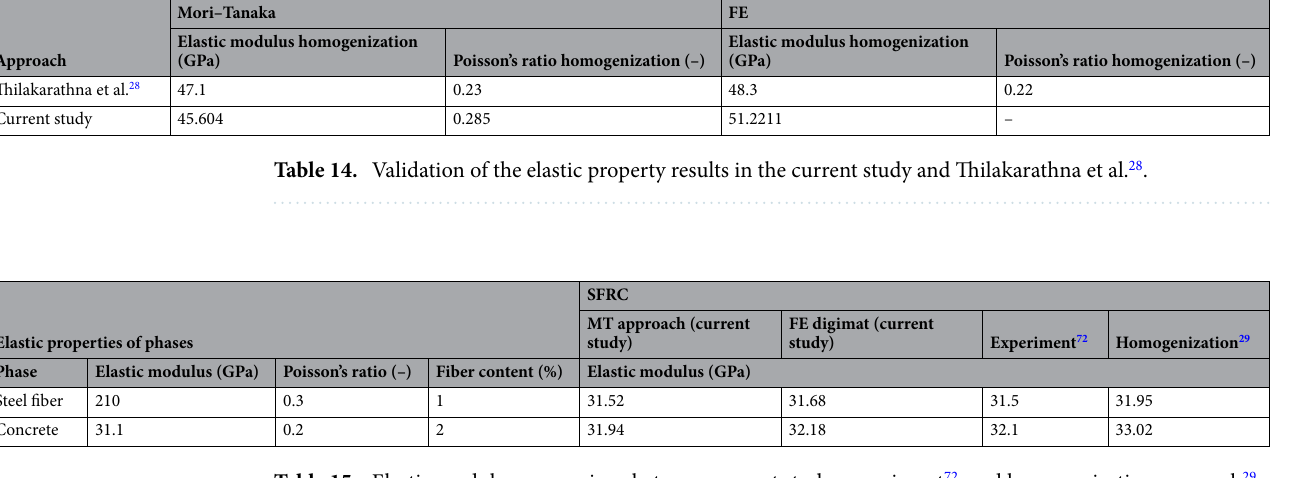
Table 15. Elastic modulus comparison between current study, experiment 72 , and homogenization approach 29 .